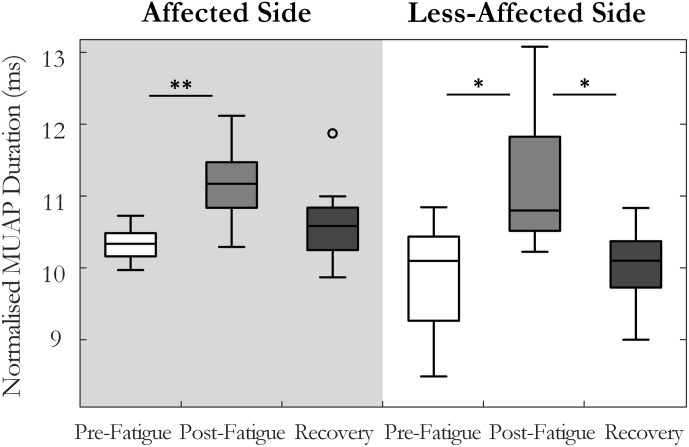
Median and interquartile range of the median MU action potential duration across all subjects from MUs detected pre-fatigue, post-fatigue, and after the recovery period, on both the affected and less-affected sides (∗p < 0.05, ∗∗p < 0.01).